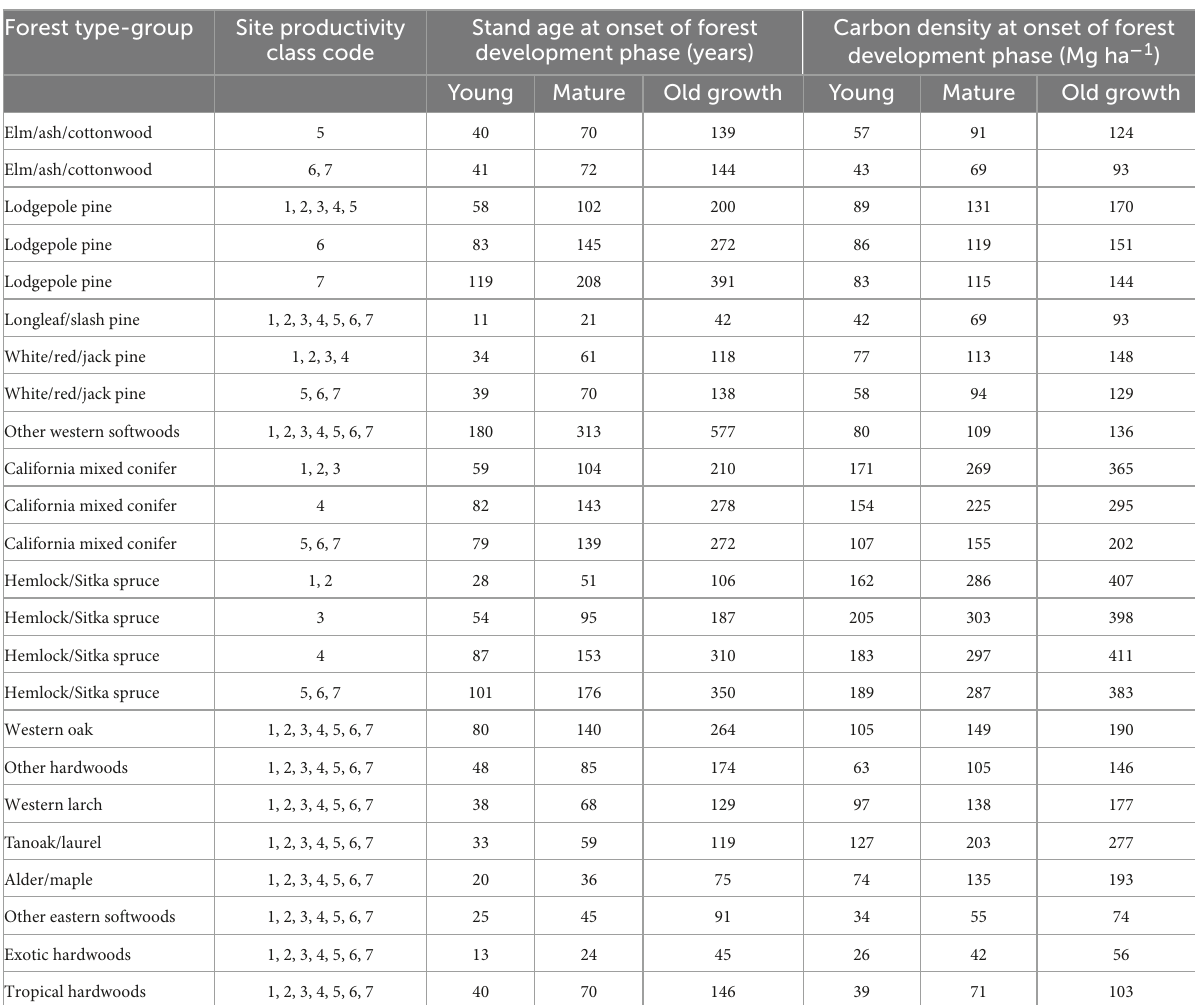
( Table 1 ). This approach yielded highly variable ages at the onset of old growth within and among forest type-groups, ranging from 34 to 577 years ( Table 2 ). The age at onset of old growth was estimated to be less than 100 in 10 of 60 models, half of which were in gymnosperm forest type- groups found in the eastern United States ( Figure 3 ). The age at onset of old growth for western gymnosperm forest type- groups (e.g., Hemlock/Sitka spruce, Lodgepole pine,